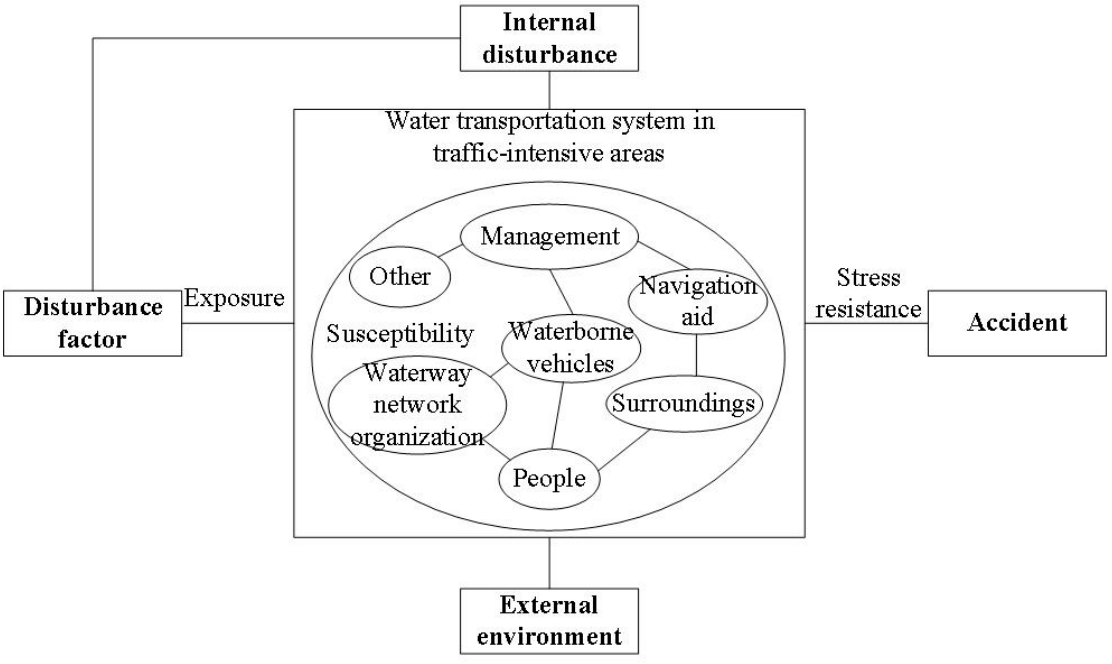
Figure 1. Water transportation system vulnerability mechanism.